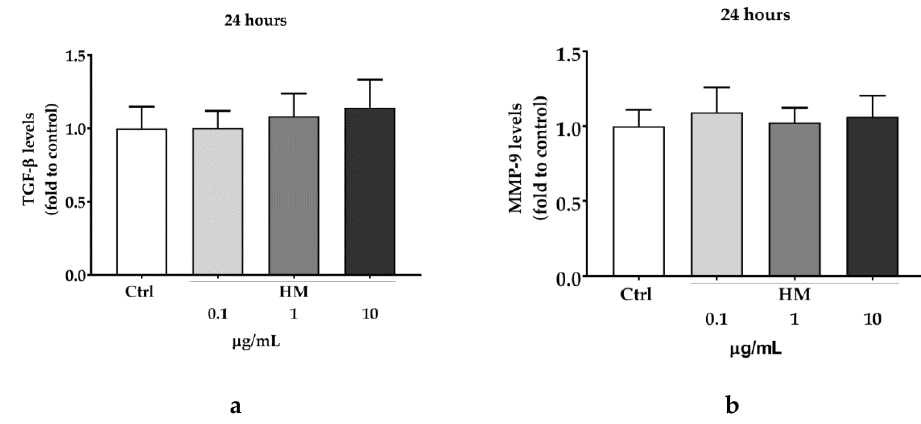
Figure 5. Effect of HM on TGF- β levels ( a ) and MMP-9 release ( b ). HaCaT cells were treated with increasing concentrations (0.1 to 10 μg/mL) of different extract (as indicated) or DMSO (Ctrl) for 24 h. TGF- β levels and MMP-9 release were assessed by non-competitive sandwich ELISA. Data are expressed as mean ± SD of three independent experiments and normalized to the Ctrl value. One-way ANOVA was used for determining the statistical differences between groups.